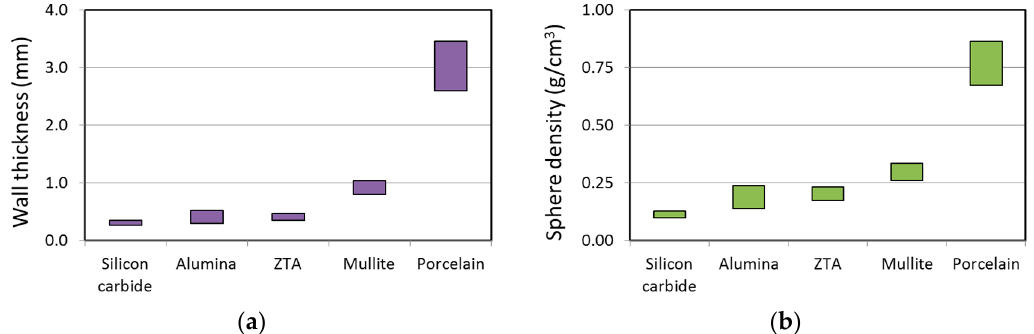
Figure 2. Comparisons of calculated ( a ) wall thickness and ( b ) sphere density of the hollow sphere with a radius of 25 mm made from various engineering ceramic materials that can theoretically withstand 105 MPa of compressive burst pressure. ZTA = zirconia toughened alumina.